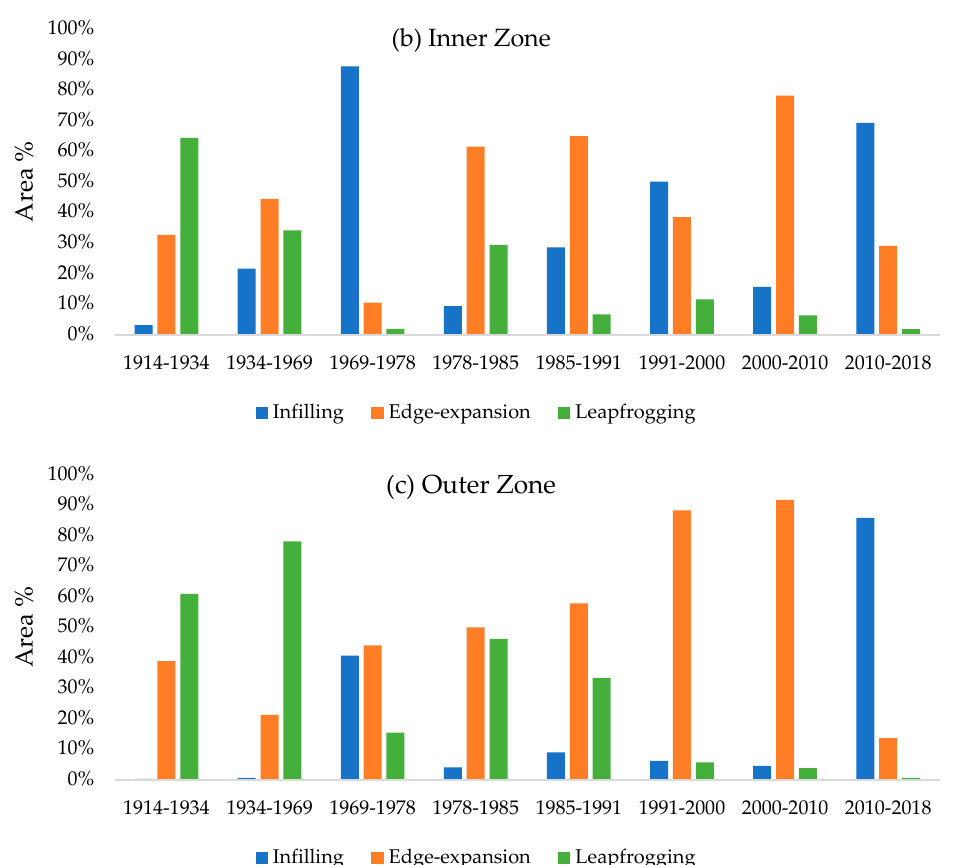
Figure 5. The relative dominance of urban growth types (infilling, edge-expansion, and leapfrogging) in Hangzhou from 1914 to 2018.